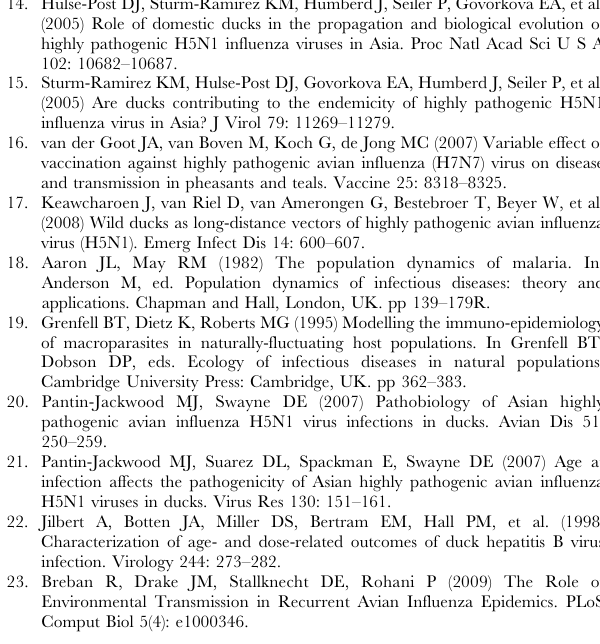
Table S2 Sensitivity of epidemiological parameters for peak prevalence and proportion of the population dying from AI. The model describes disease dynamics in a population of 10000 individuals during 60 days. We used Latin Hypercube Sampling (N = 30, 100 runs) and a semi partial correlation coefficient (SPC) to measure the relative influence of model parameters. See text for additional